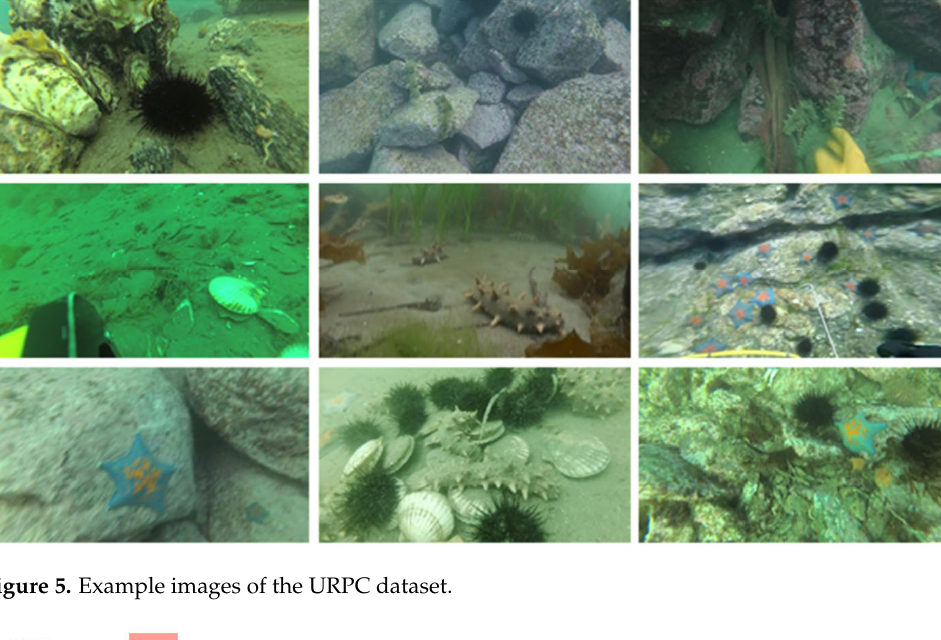
Figure 5. Example images of the URPC dataset.